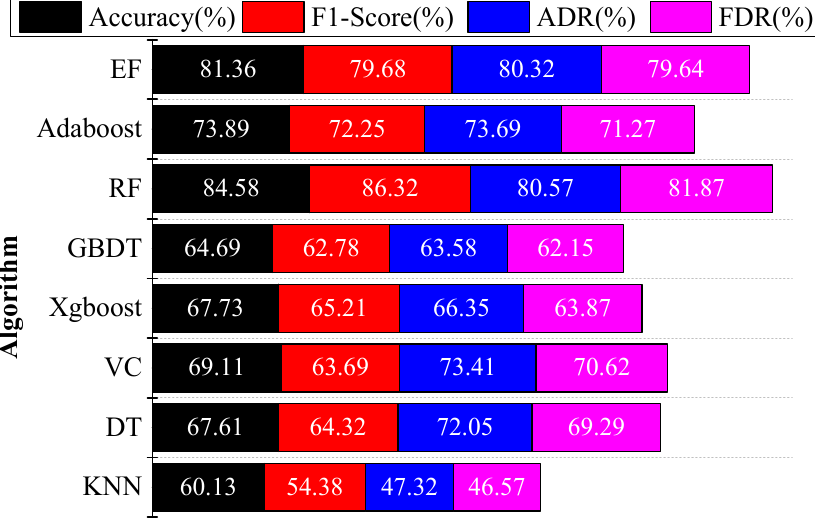
Figure 10. Performance comparison of different algorithms. The average detection precision of the CIKS–MFS–FLGB method for attack detection is 94.09% and the average F1 score is 93.61%. In general, the four indexes of the CIKS–MFS– FLGB are higher than the above eight algorithms. Among them, the accuracy increased by 21.75% on average, the F1 score increased by 24.87% on average, the attack detection rate increased by 23.96%, and the fault detection rate increased by 25.25%. After data